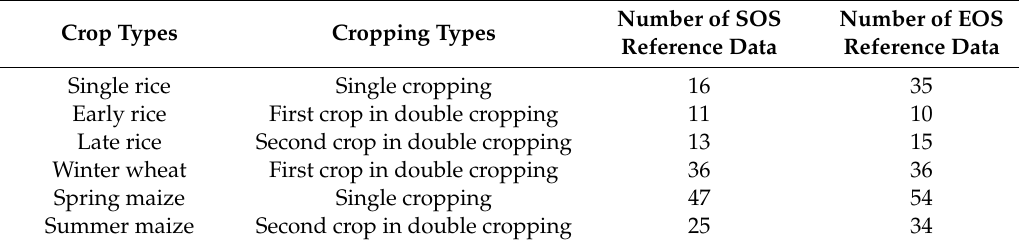
Table 1. Number of available reference data for each